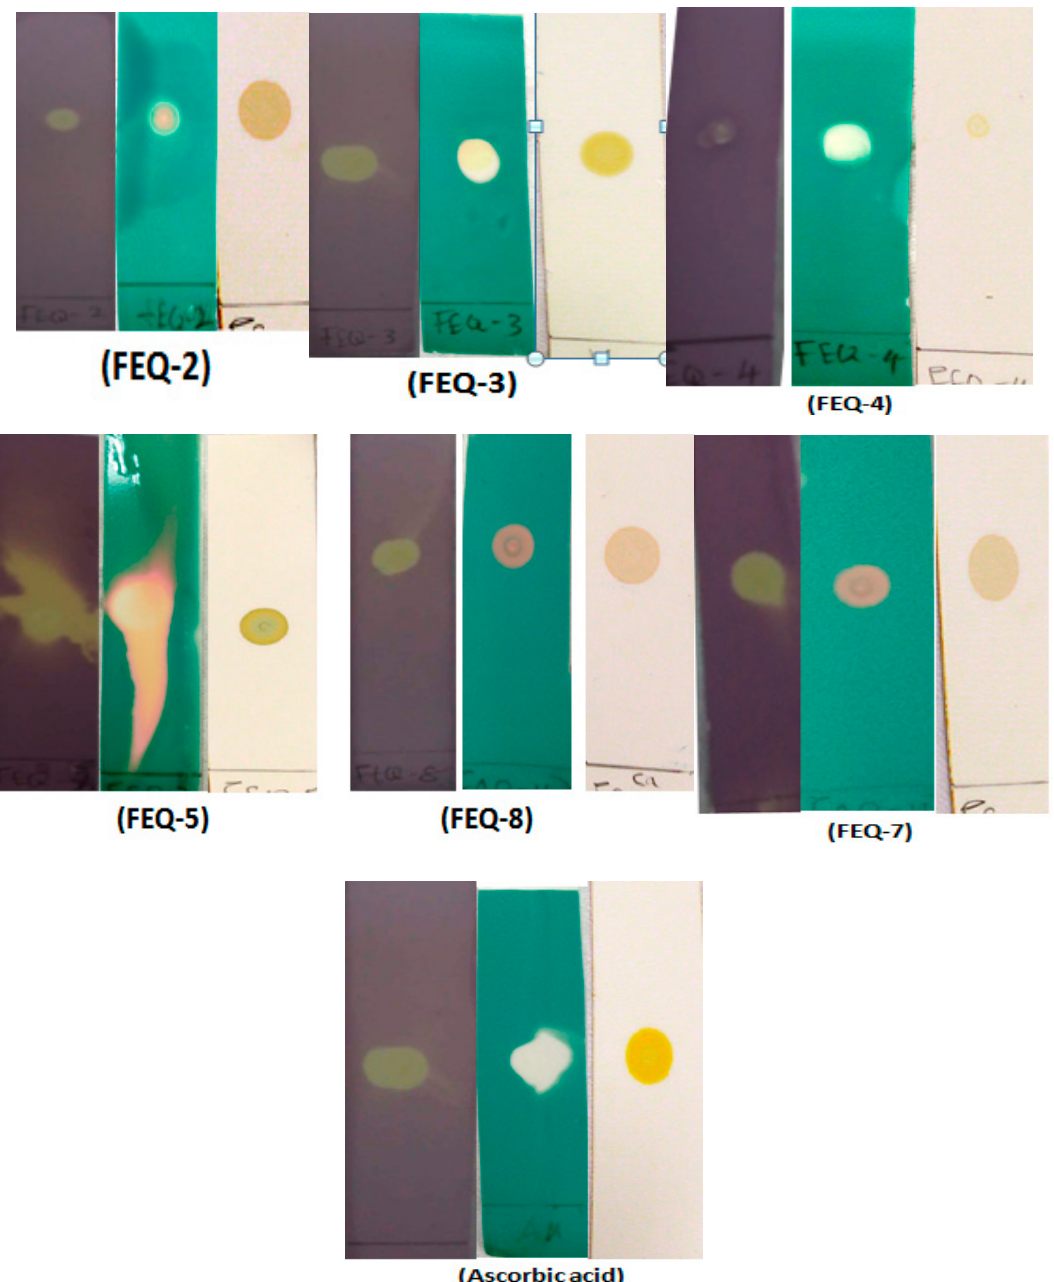
Figure 1. Result of the Dot-blot staining assay for the isolated compounds. Purple-background plate (plate sprayed with DPPH reagent), blue background plate (plate sprayed with ABTS reagent),